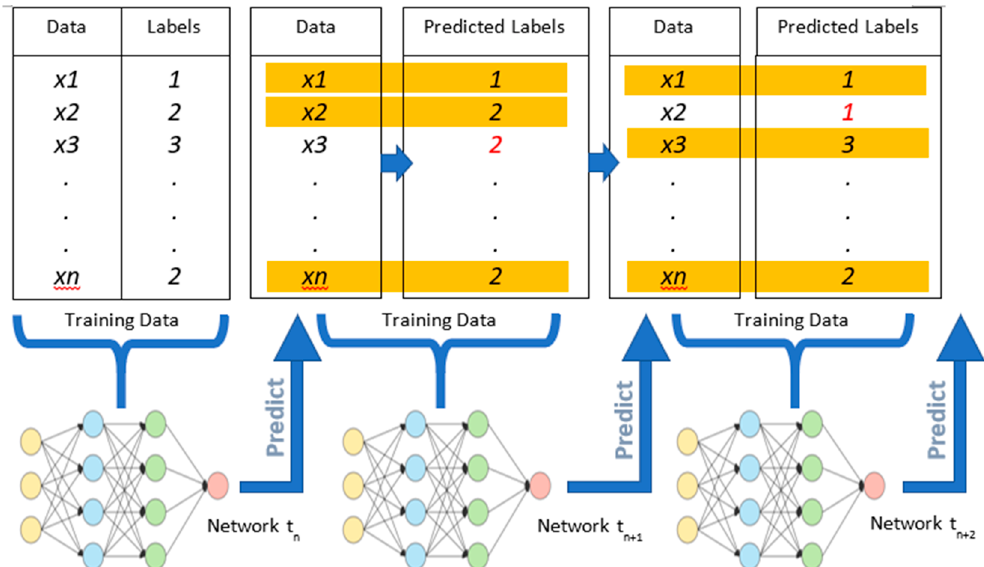
Figure 5. Visual representation of the processes involved in the self-learning approach. In each step, the previously obtained model is used to predict labels at the new time point. The network is then updated/retrained using these predicted datasets, at the current point in time. Here, the highlighted text represents correctly predicted samples, while red text represents mislabeled samples, both of which may be incorporated into a “self-labelled” dataset depending on the confidence level.